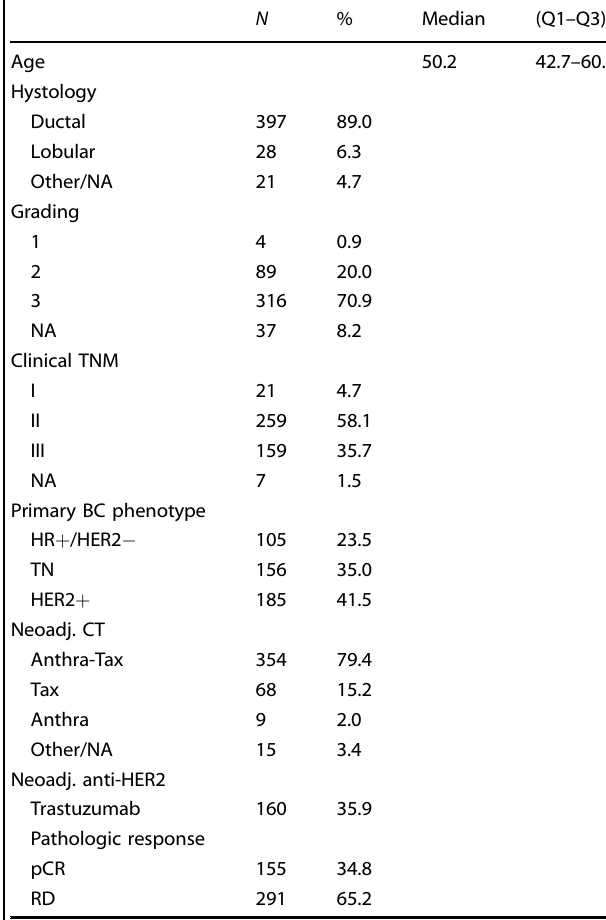
Table 1. Main clinicopathologic characteristics.